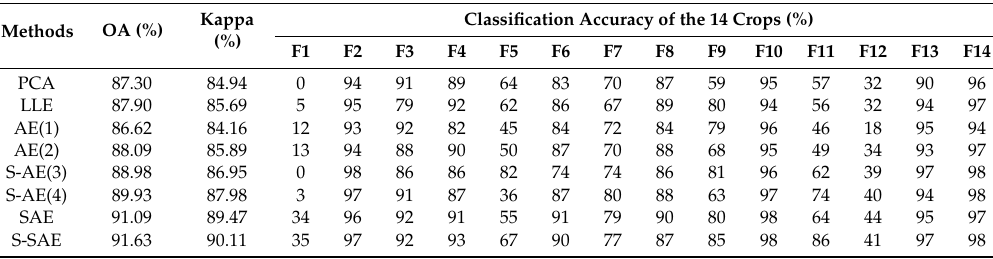
Table 9. Comparison of CNN classification accuracy with di ff erent dimension reduction methods in Flevoland site.